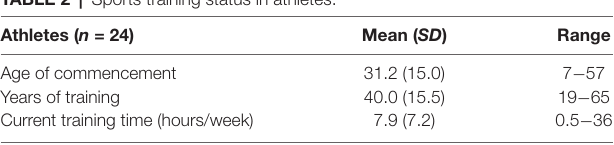
TABLE 2 | Sports training status in